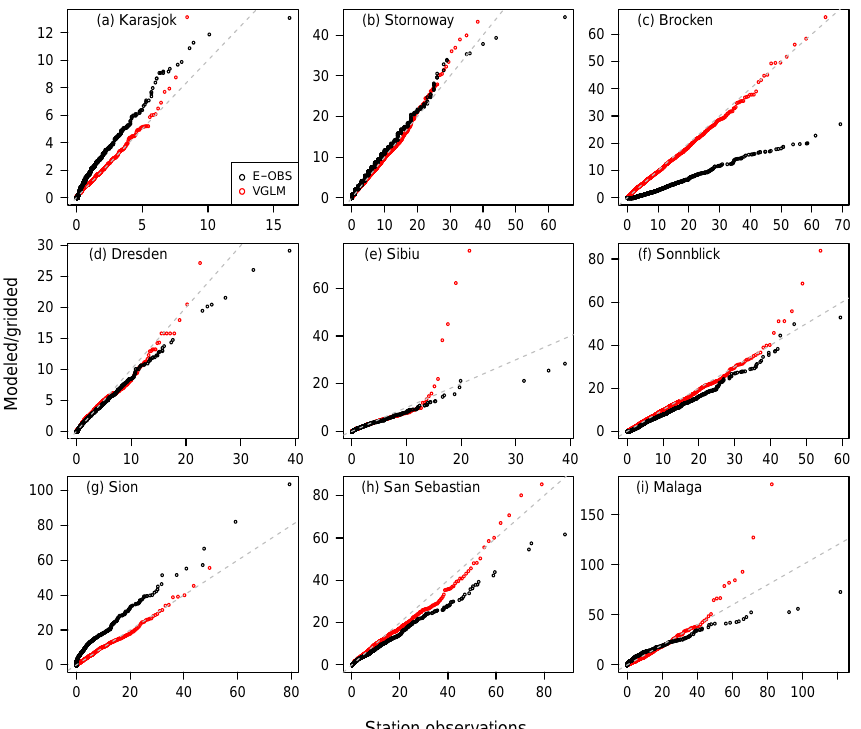
Figure 6. Step 2: downscaling. QQ plots for example stations in DJF. VGLM gamma standardized to the stationary gamma distribution fitted to observed wet day intensities between gridded and point-scale precipitation observations (mmday − 1 ). (a) Karasjok, (b)